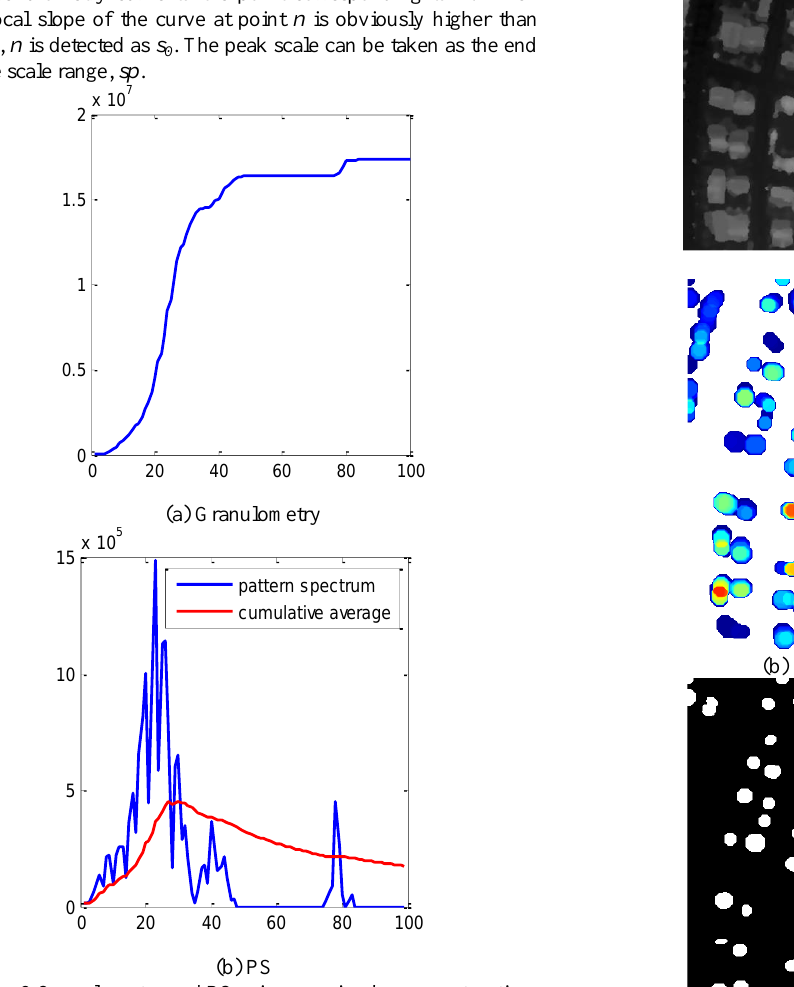
Figure 3 Granulometry and PS using